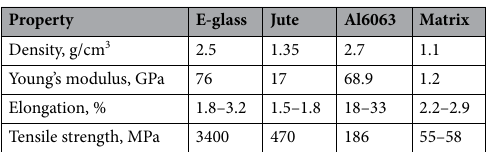
Table 1. The properties of reinforcements and matrix given by the supplier.